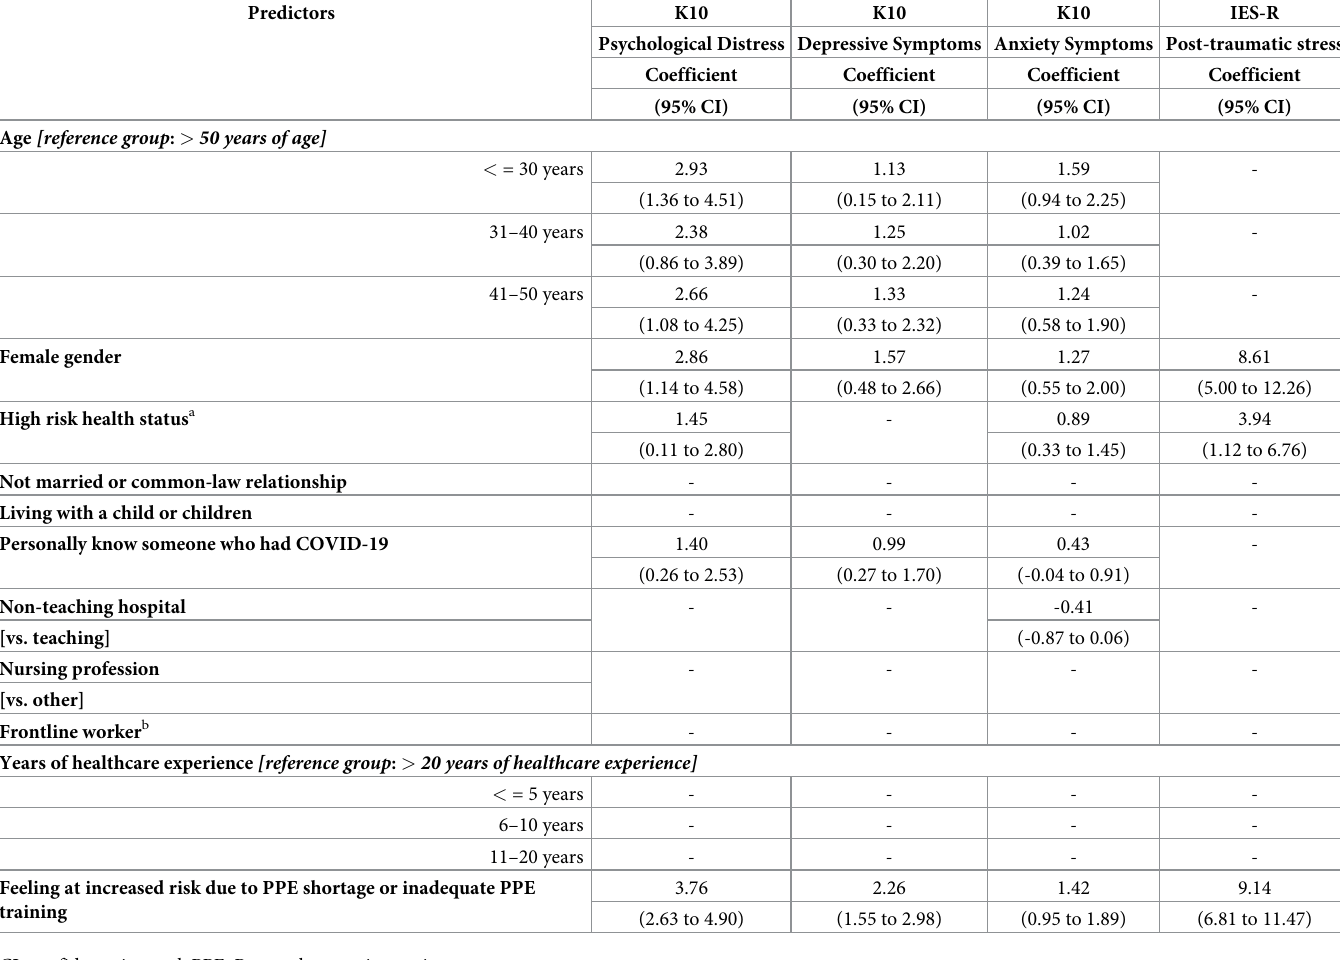
Table 3. Multivariable analysis of the predictors of psychological outcomes among hospital workers during the COVID-19